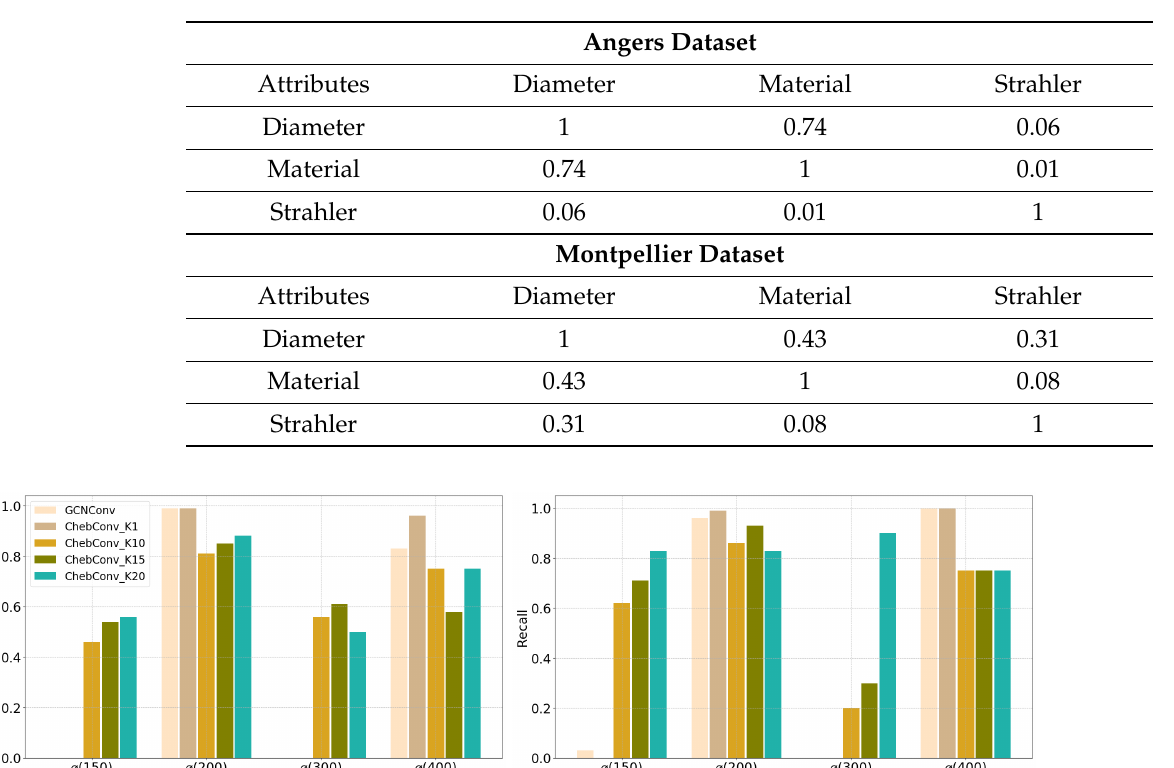
Table 3. Attributes correlations.